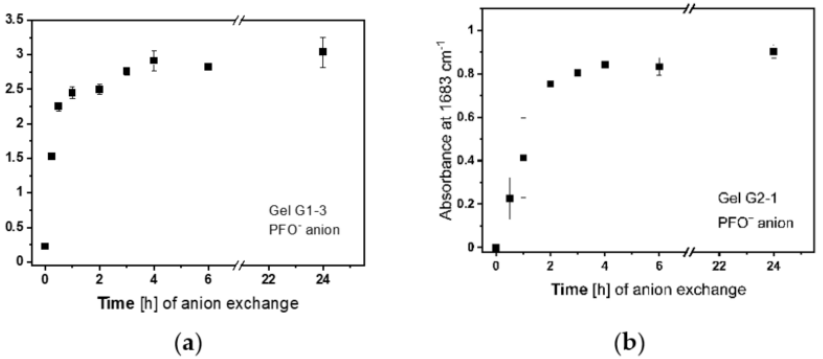
Figure 2. Kinetics of the PFO anion exchange in ( a ) the G1 and ( b ) G2 hydrogel series, monitored by FTIR at the 1683 cm − 1 absorption band, which is typical for the PFO anion. c(PFO) = 0.05 and 0.034 mol L − 1 for G1-3 and G2-1,